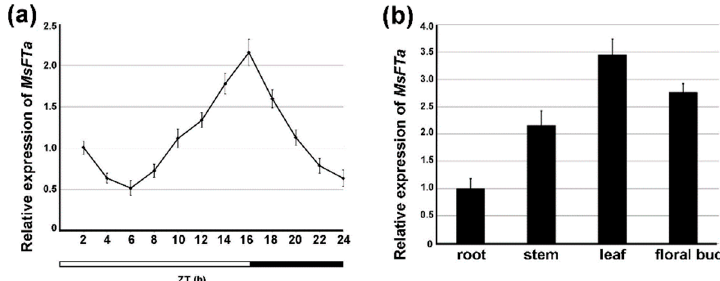
Figure 5. Diurnal and tissue-specific expression of MsFTa. ( a ) The expression level of MsFTa transcript during 24 h zeitgeber time (ZT) under LD. The white bar represents day time and the black bar represents night. ( b ) Relative expression of MsFTa in roots, stems, leaves and flowers of alfalfa at ZT 14. Bars represent the means ± SD of three biological replicates.